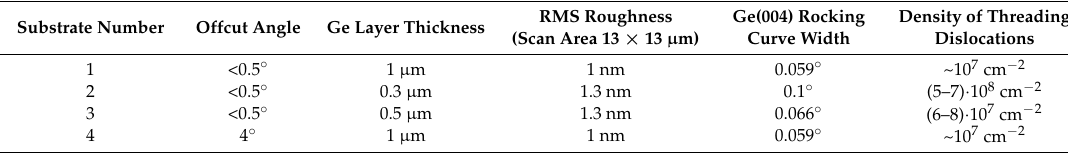
Table 1. Parameters of Ge/Si (001) virtual